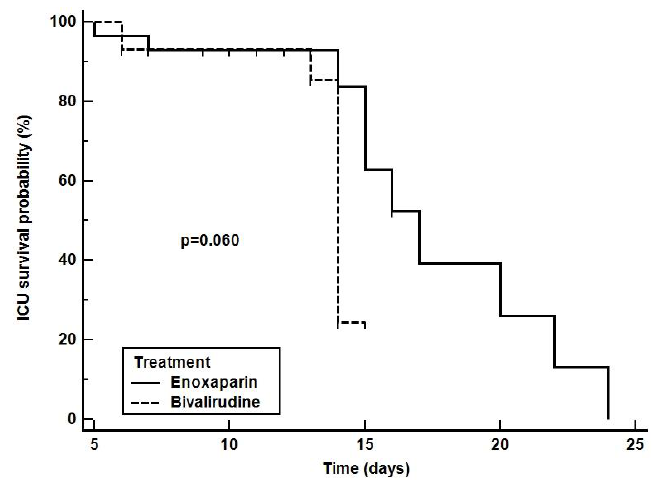
Figure 4. ICU survival. The curves depict the ICU survival in patients receiving enoxaparin (solid line) or bivalirudin (dashed line).